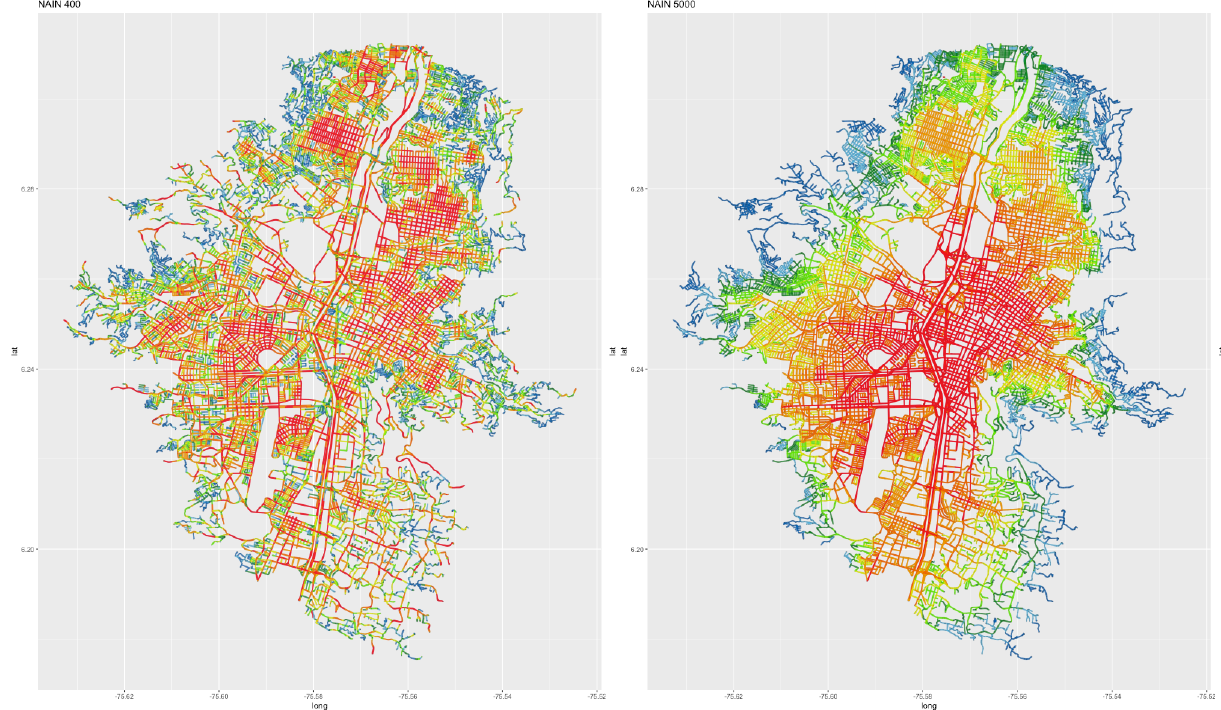
Figure 6. Urban Integration cores for Medellín, Colombia. Follows the format for Figure